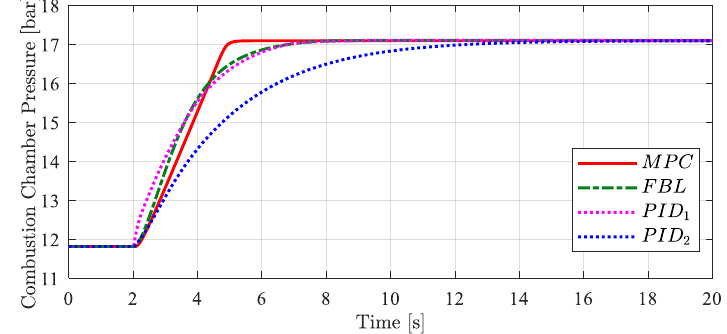
Figure 6. Combustion chamber pressure (CCP) time profile.